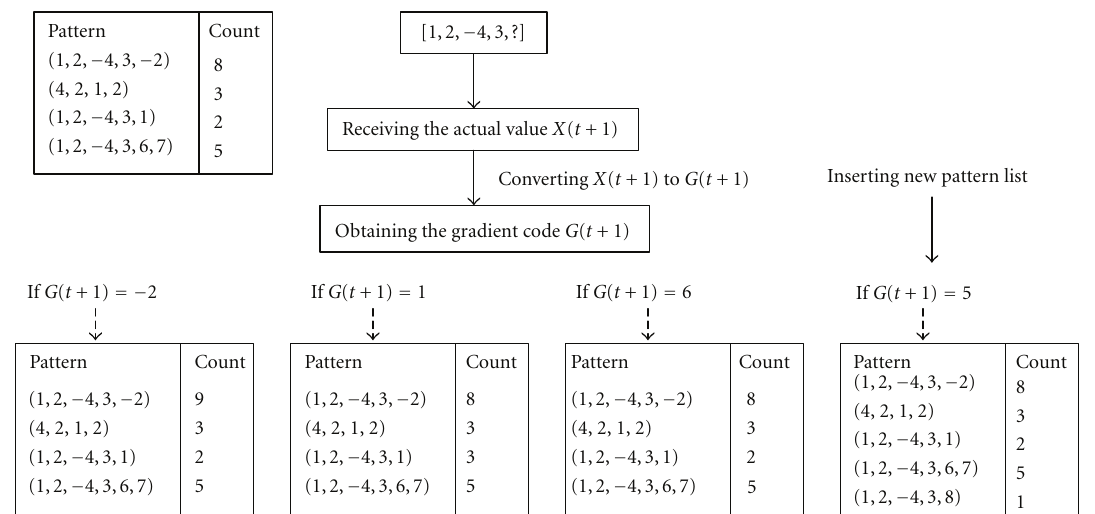
Figure 4: An example of updating the pattern